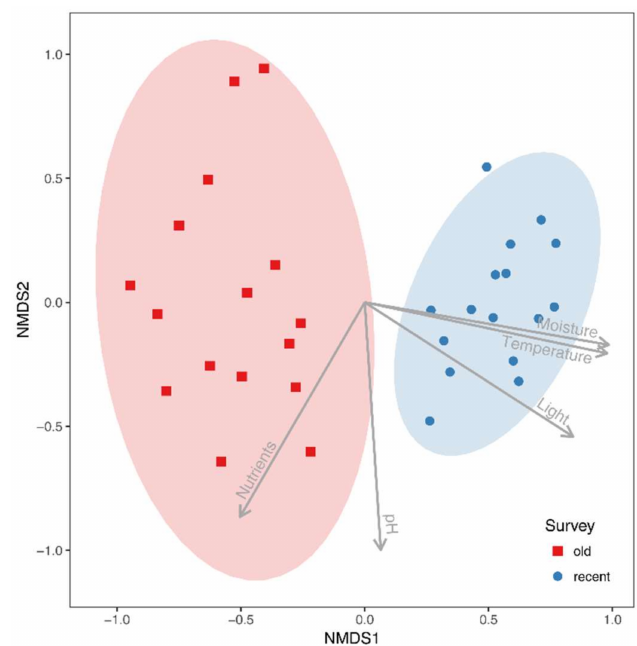
Figure 2. Comparison of species composition in alder carrs in 1993 (old survey) and 2013 (recent survey) using nonmetric multidimensional scaling with passively fitted community means of Ellenberg’s Indicator Values. Table 2. Comparison of mean EIVs between surveys in 1993 and 2013 using modified permutation test [46]. 1993 2013 EIVs F -value p x − SD x − SD Light